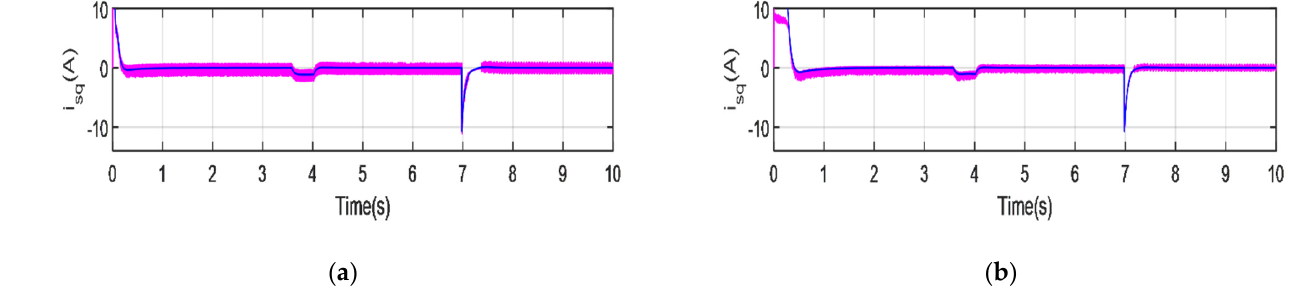
Figure 16. Isq components: ( a ) conventional inverter; ( b ) five-level inverter.